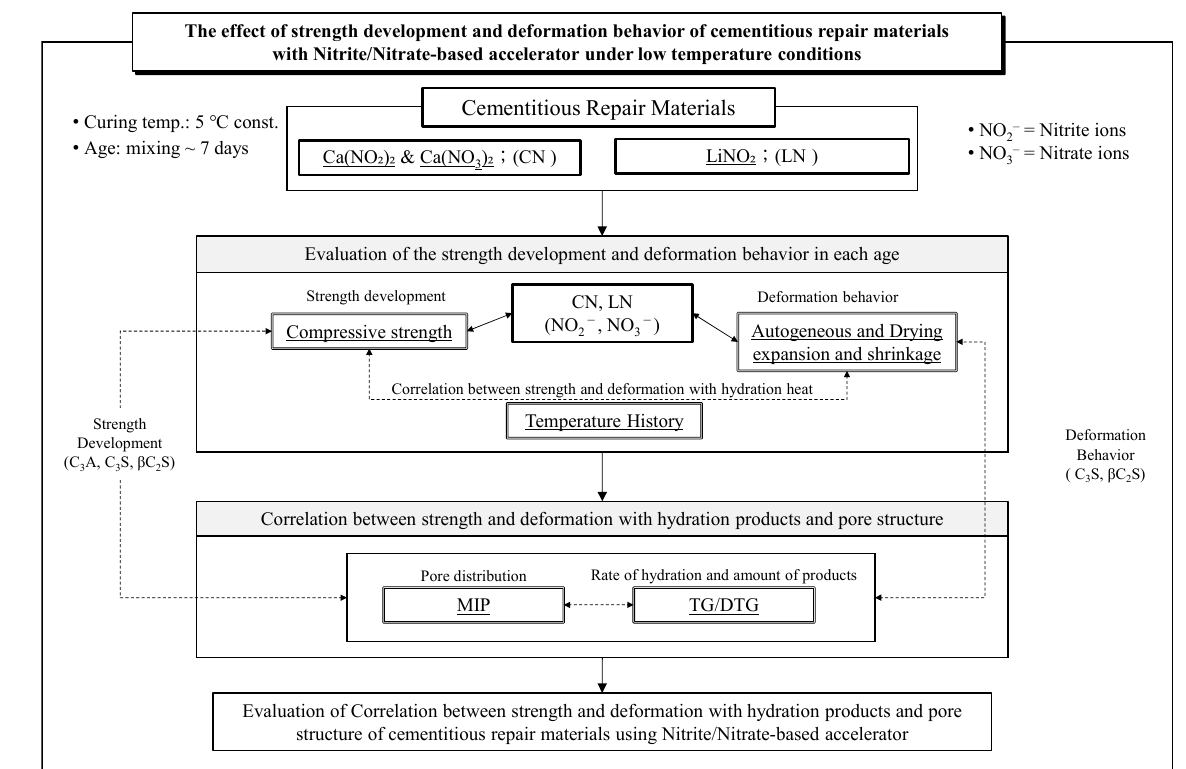
Figure 1. Study Flow Chart.